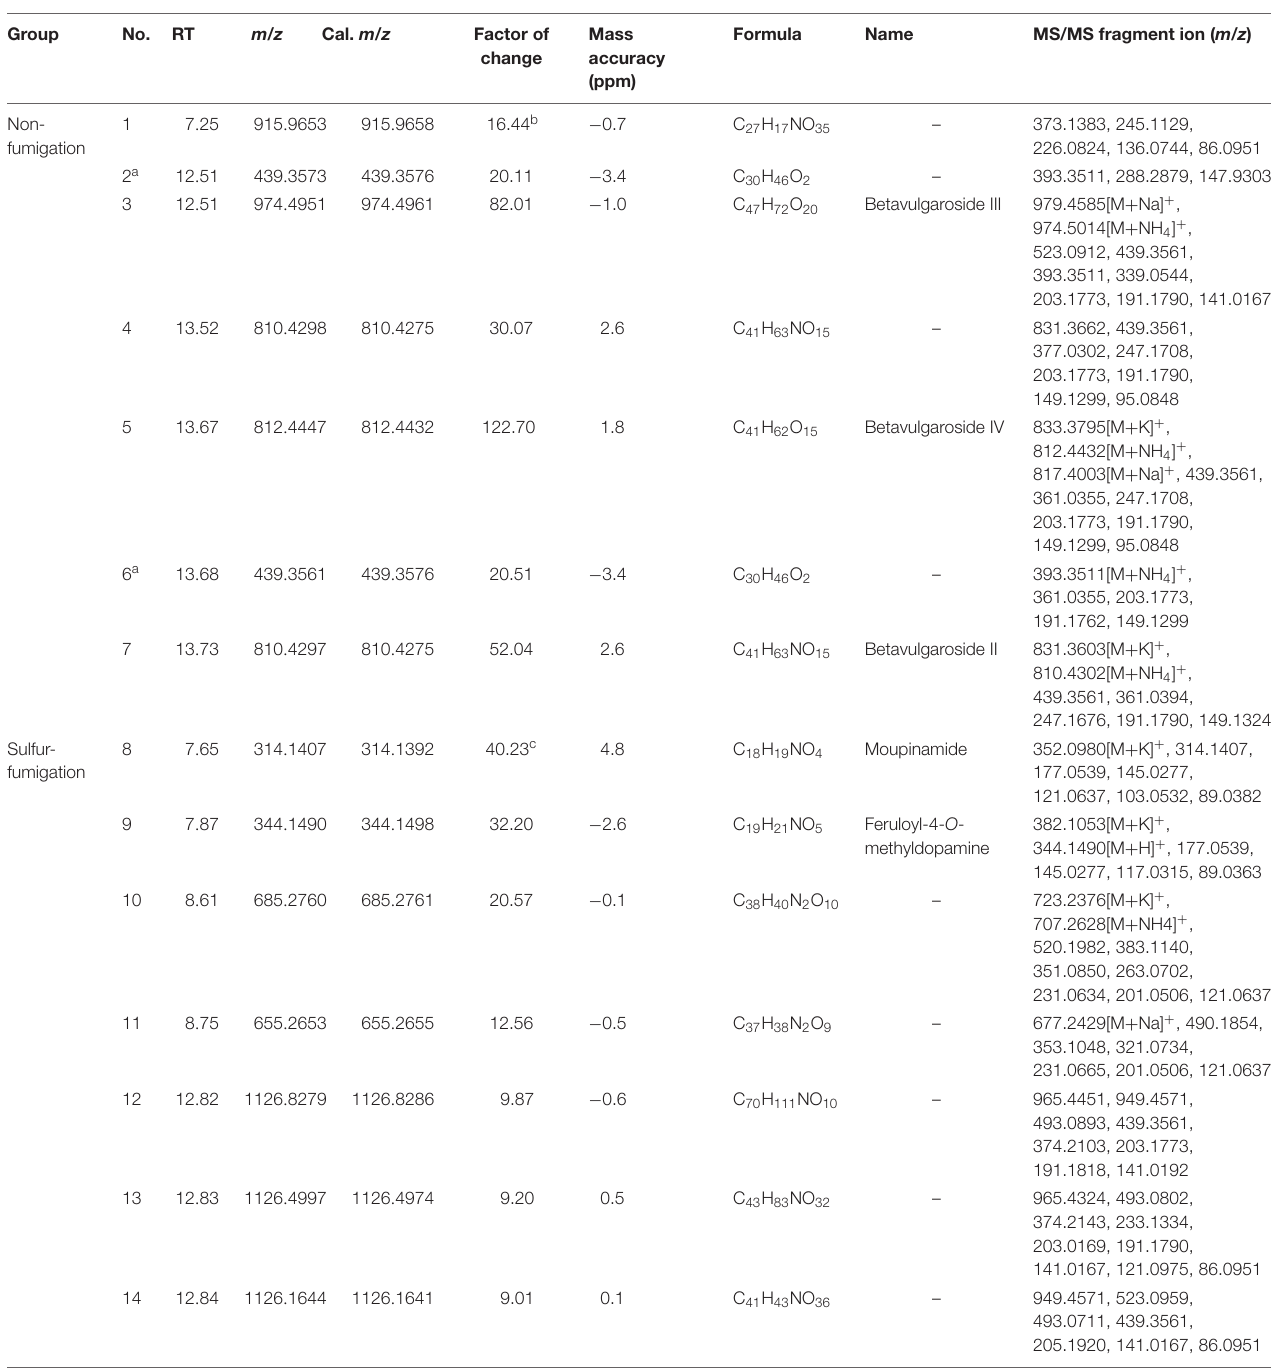
TABLE 1 | Fourteen marker ions of non-fumigated and sulfur-fumigated AB samples in positive mode. Group No. RT m/z Cal. m/z Factor of